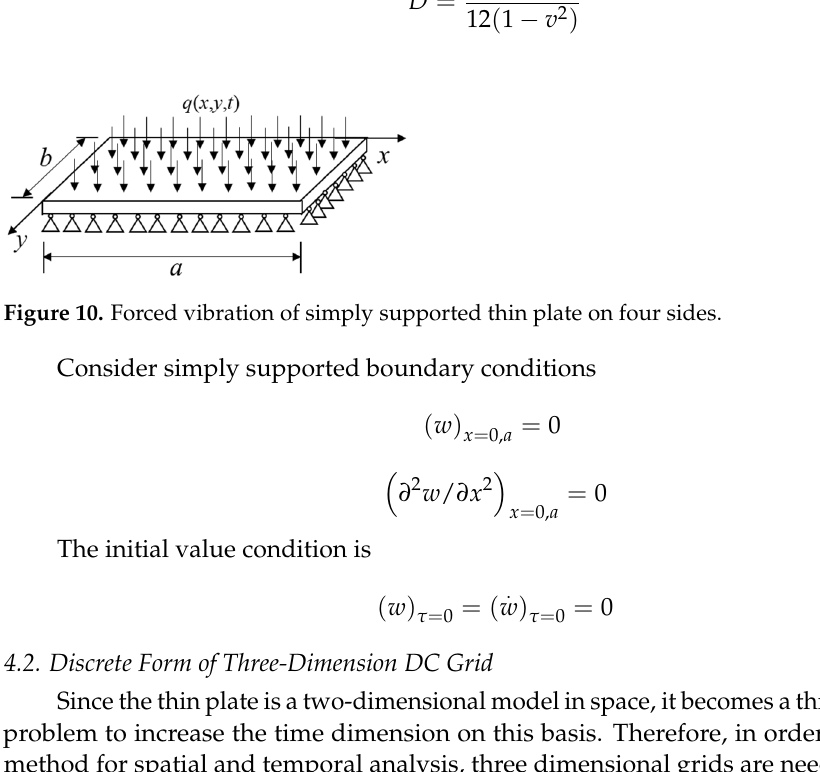
Figure 11. Three-dimensional orthogonal mesh.